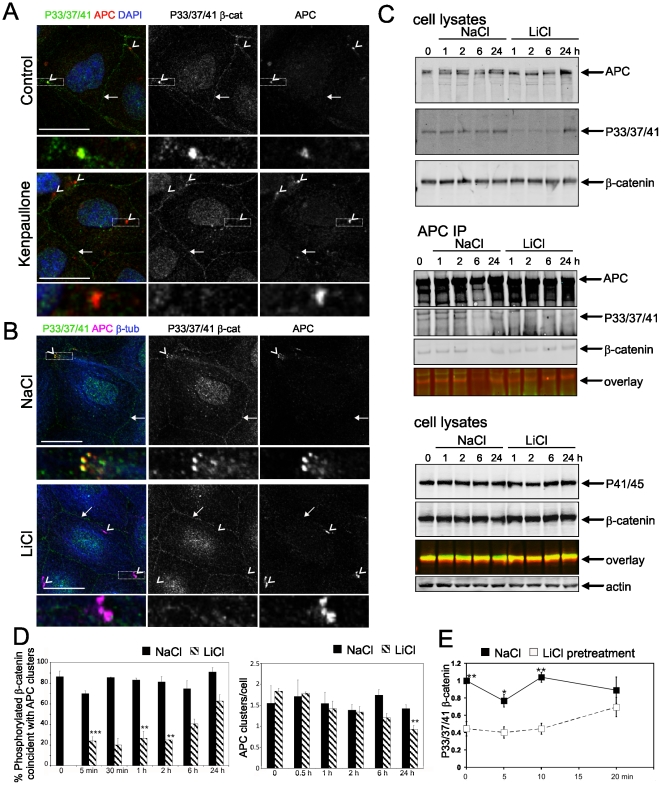
Inhibition of GSK3β results in loss of P33/37/41-β-catenin associated with APC but not other sub-populations.(A) Kenpaullone (2 nM, 30 min) and (B) LiCl (30 mM, 5 min) treatment of MDCK cells results in loss of P33/37/41-β-catenin coincident with APC. APC clusters (arrowheads) are coincident with P33/37/41-β-catenin in control but not kenpaullone or LiCl treated cells; intact peripheral staining is indicated by arrows. Scale bars 20 µm. (C) LiCl treatment results in reduced P33/37/41-β-catenin in total cell lysates and associated with APC, but not P41/45-β-catenin. Lysates from MDCK cells treated with 30 mM NaCl or LiCl for T0, 1, 2, 6 and 24 h were immunoblotted or immunoprecipitated with APC antibodies and immunoblotted as indicated. Overlay refers to the merge of P33/37/41 or P41/45-anti-rabbit-IR800 and β-catenin-anti-mouse-IR680 channels. (D) Analysis of coincident P33/37/41-β-catenin and APC clusters following GSK3β inhibition. MDCK cells were treated with 30 mM NaCl or LiCl for the indicated times, fixed and immunostained. Cells were scored for coincident P33/37/41-β-catenin and APC clusters (left) and number of APC clusters/cell (right). Shown is average +/− SEM from three (T0, 5 min, 1, 2 6 and 24 h) or two (T30 min) independent experiments, >100 cells per treatment group; ***P<0.001, **P<0.01 by Student's t-test. (E) Removal of GSK3β inhibition allows re-phosphorylation of β-catenin. MDCK cells pretreated with 30 mM NaCl or LiCl for 30 min, were incubated in DME+10%FCS and harvested at T0, 5, 10 and 20 min. Lysates were immunoblotted with P33/37/41 β-catenin and actin antibodies. Shown is average +/− SEM from four independent experiments for normalised densitometry values, *P<0.05, **P<0.01 by Student's t-test. A representative blot is shown in Fig S10A.